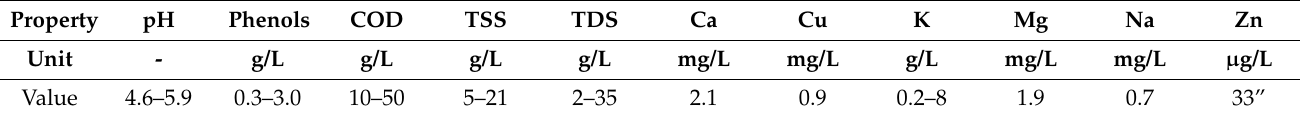
Table 3. Characterization of OMW in Jordan. Adapted from References